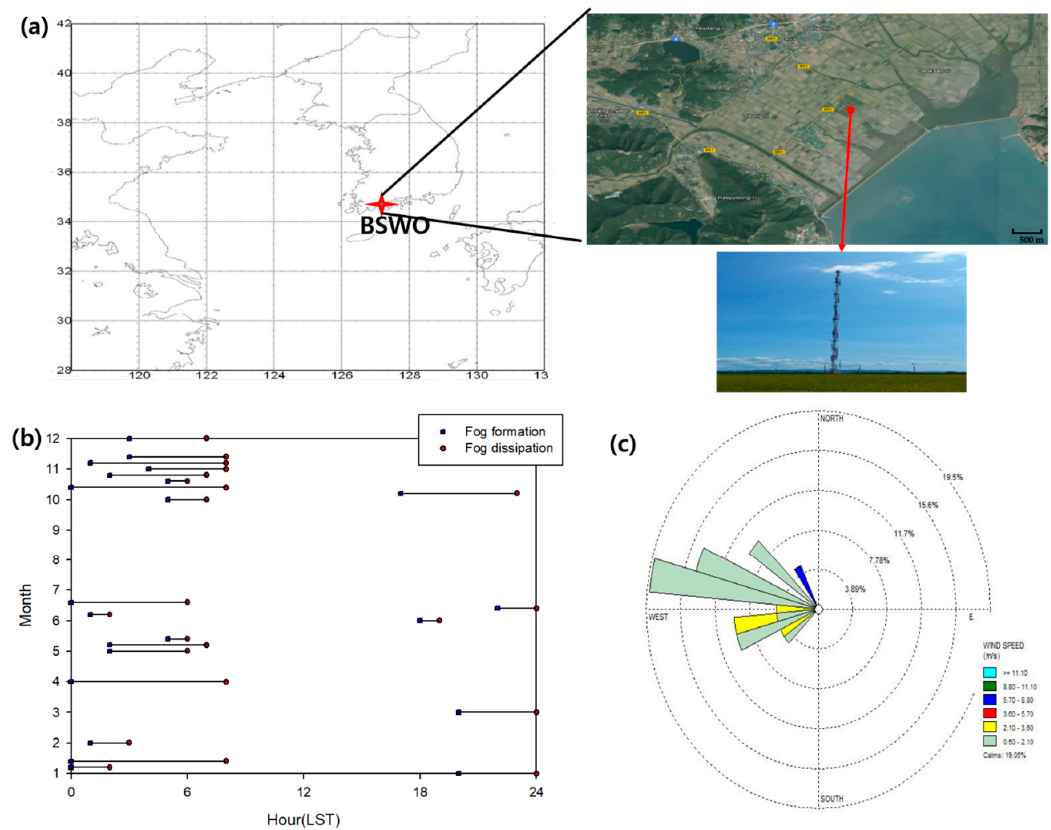
Figure 1. ( a ) Location of Boseong Standard Weather Observatory (BSWO); ( b ) fog onset and dissipation time for each fog case; and ( c ) wind rose distribution during the